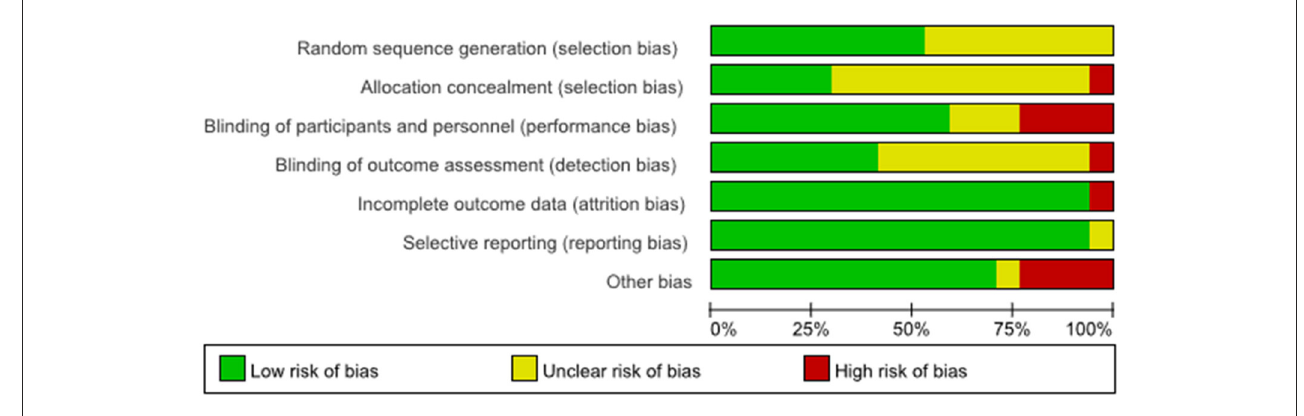
FIGURE2 Risk of bias